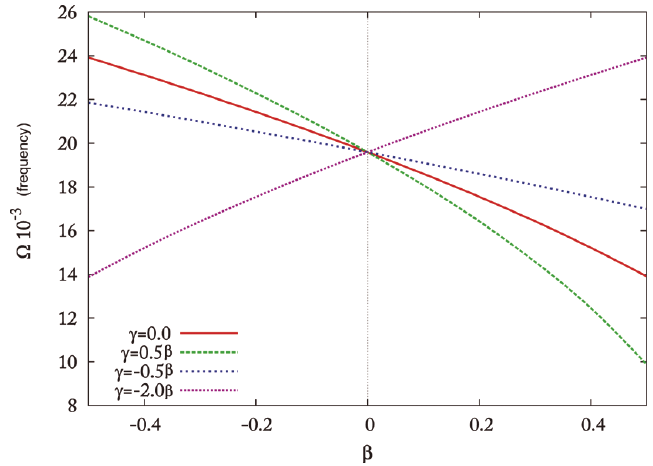
Fig. 13. PLATE-43 ( θ = 45 ◦ ), LD1, a/h = 30, a = b,